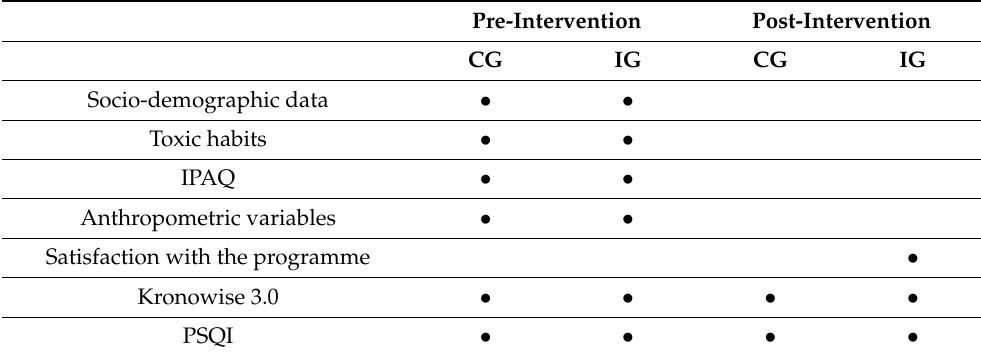
Table 2. Data collection and follow-up